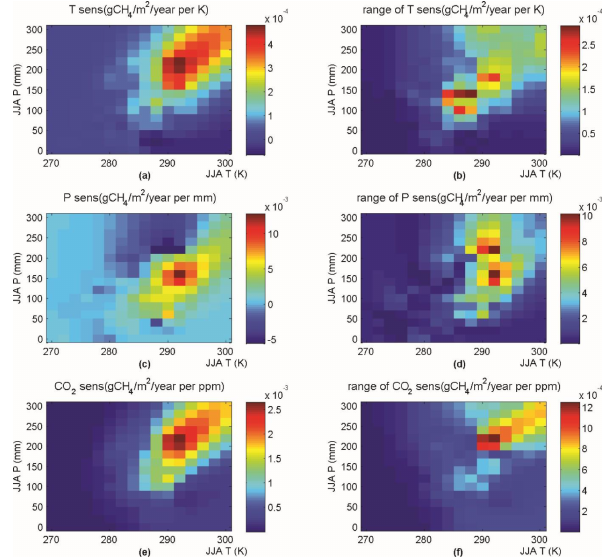
Figure 9. The 1960–2006 average T , P and CO 2 sensitivities ( a , c , and e , respectively) of CH 4 emissions in JJA T and JJA P space using the median methane model parameter set and their ranges at the 95% confidence level across randomly sampled methane model parameter sets ( b , d , and f ,